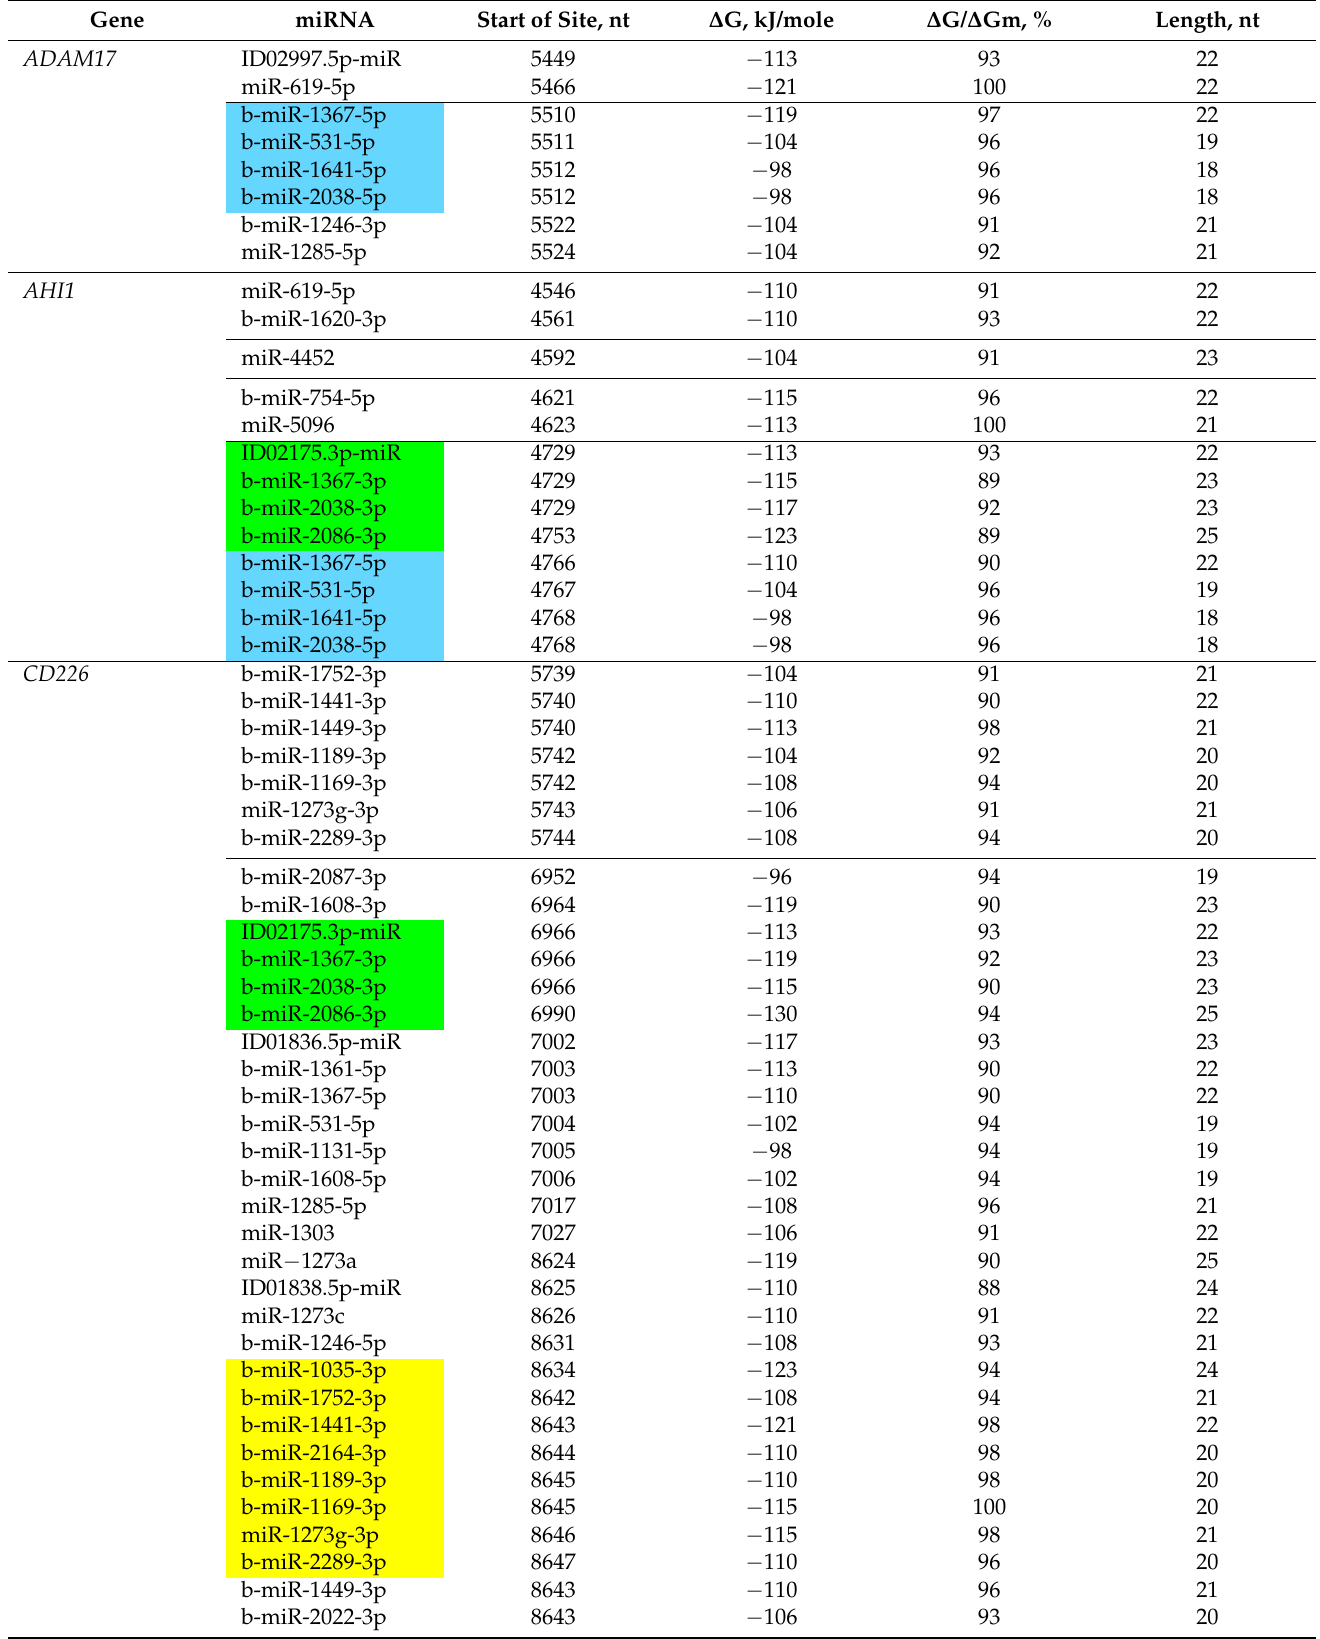
Table 3. Characteristics of miRNA interactions with 3 (cid:48) UTR mRNA of MS candidate genes. Gene